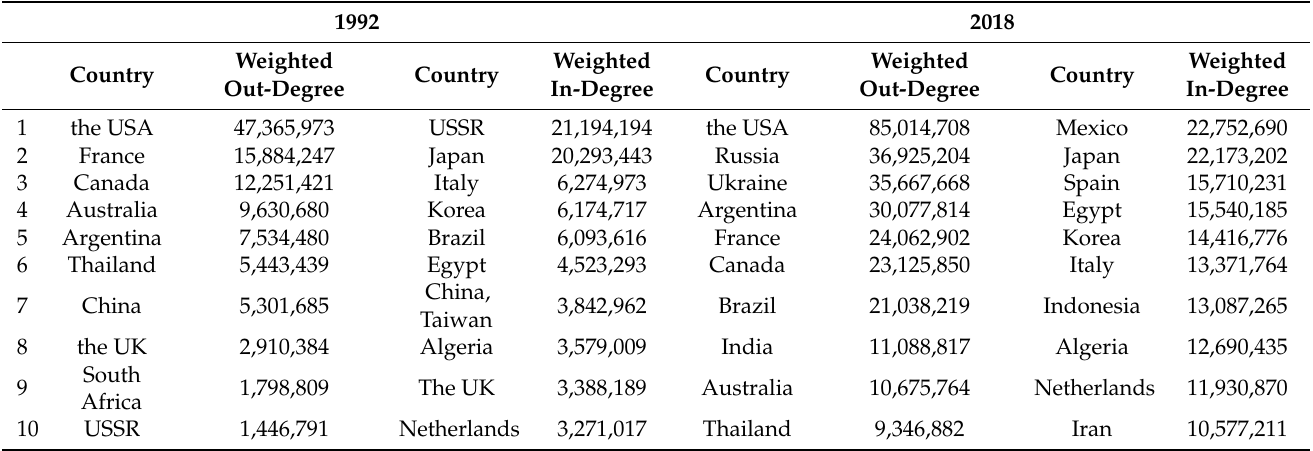
Table 4. Top countries by weighted degrees from 1992 to